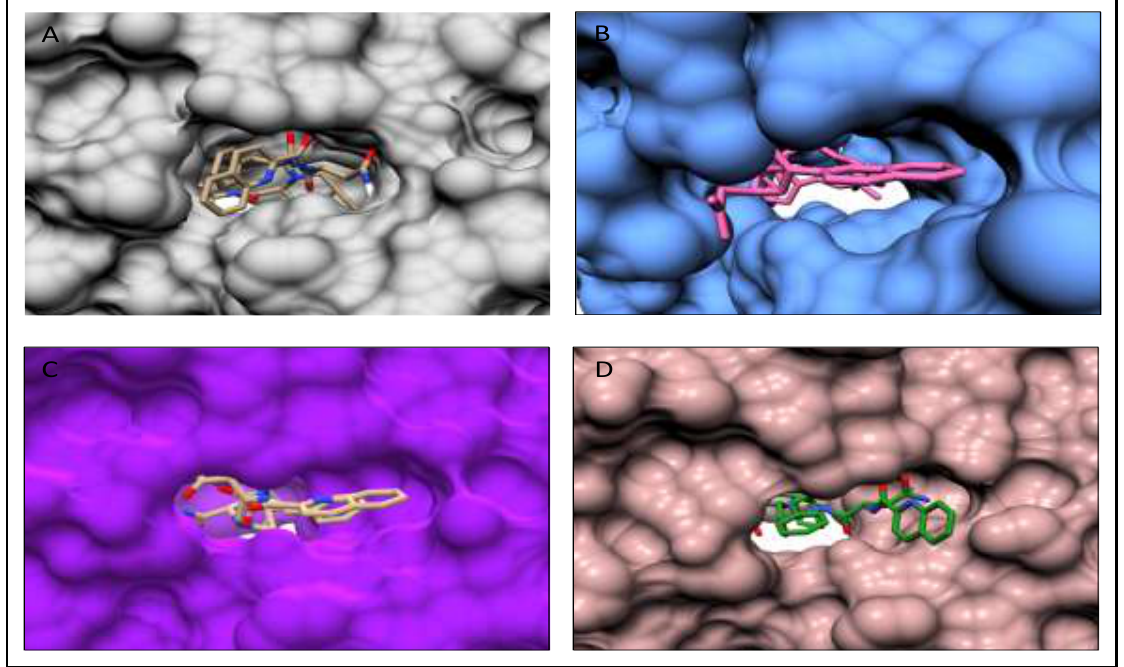
Figure 3. Saquinavir-HIV-1 complex conformation of the top-scored docking results and the crystal structure. A) X- ray crystal structure of the HIV-1 protease active binding site bound with saquinavir. The enzyme shows in grey when the ligand is entirely in its pocket, B) AutoDock Vina conformation of the enzyme pocket (blue) and saquinavir (pink), C) 1-Click Docking conformation of the HIV-1 protease binding site, which is in violet and the ligand, D) UCSF DOCK6 conformation of the HIV-1 protease binding site and upturned saquinavir in the receptor’s pocket.